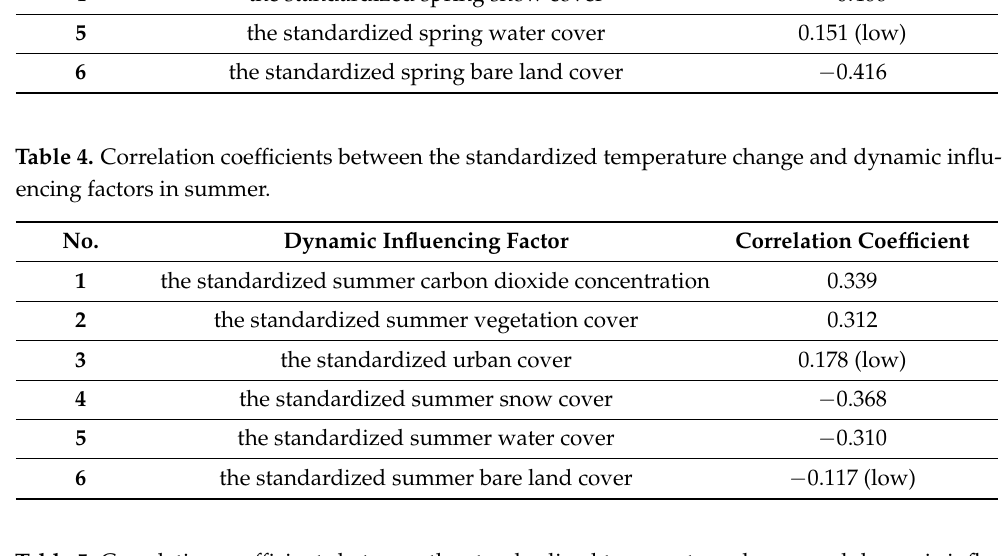
Table 5. Correlation coefficients between the standardized temperature change and dynamic influ- encing factors in autumn.